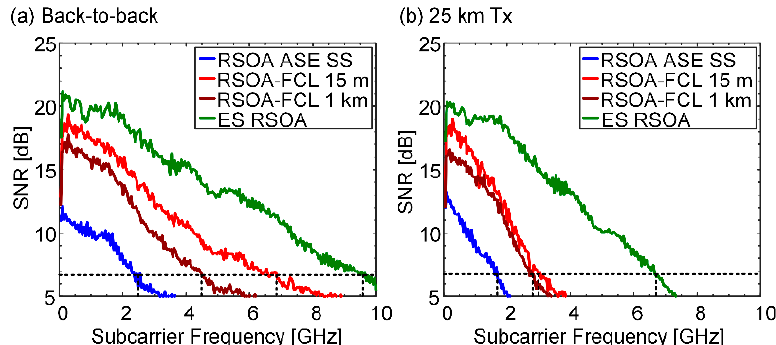
Figure 9. Comparison of the measured SNR for the three colorless transmitter schemes: RSOA ASE spectrum-sliced (SS), self-seeded RSOA-FCL and externally seeded (ES) RSOA. ( a ) Shows the BtB (back-to-back) SNR measurement. The externally seeded RSOA (green line) outperforms the RSOA-FCL (red and brown) and the ASE spectrum-sliced scheme (blue) by ~10 and ~5 dB SNR across the whole frequency range, respectively; ( b ) Shows the SNR after 25 km NZDSF transmission. The SNR bandwidth is reduced due to dispersion of the transmission fiber. In general, the RSOA-FCL offers performance midway between an ASE spectrum sliced and an externally seeded RSOA.